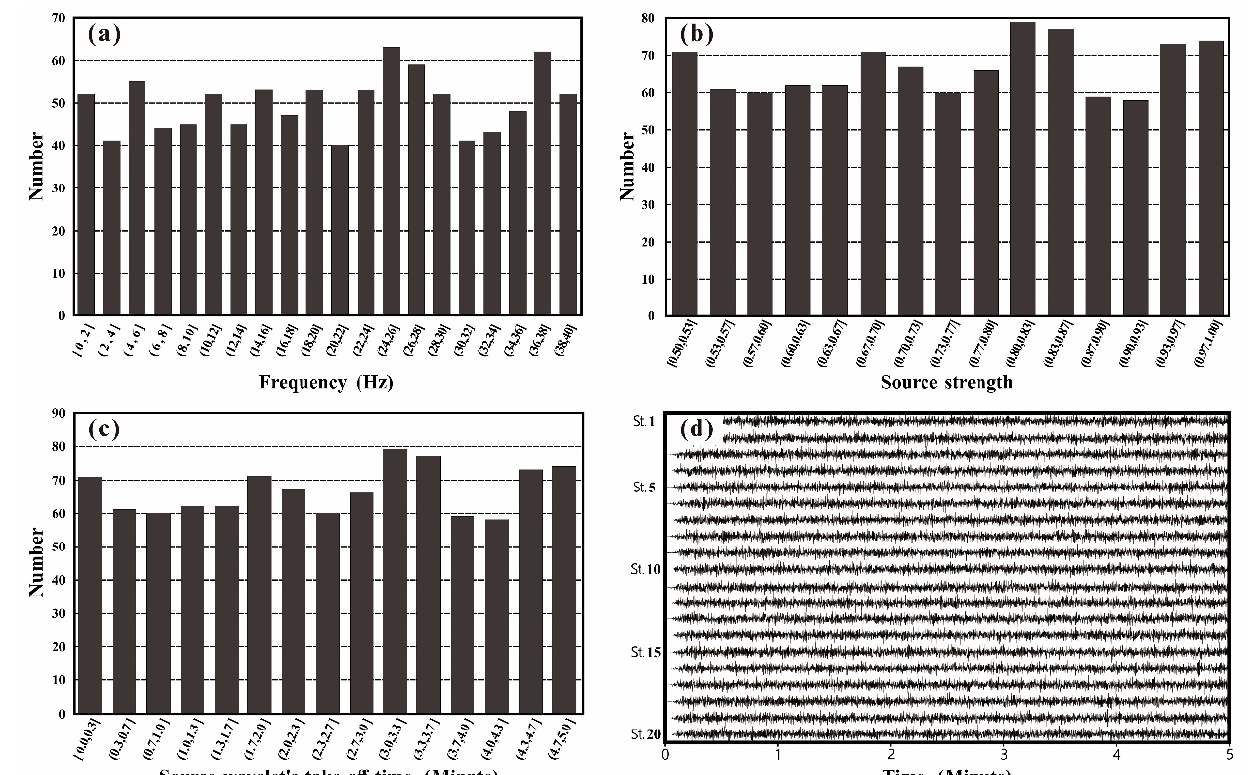
Figure 1. Spatial distribution diagram of random sources and observation array: ( a ) random sources; ( b ) observation array.